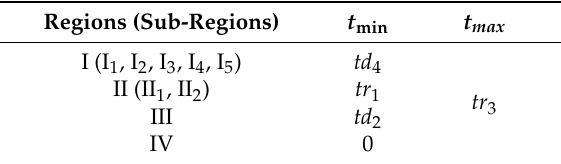
Table 4. Time instant range, [ t min , t max ], for each region/sub-region. Regions